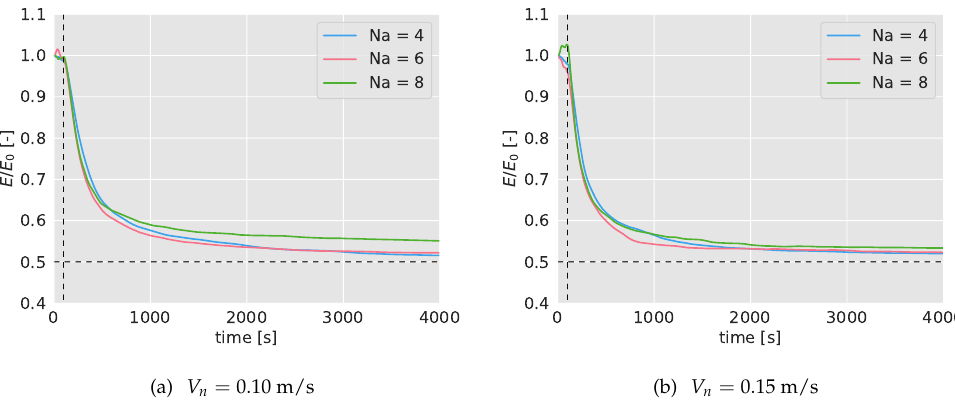
Figure 9. Efficiency of the algorithm over time when half of the agents are forced to land at t = 100 s, marked with a black dashed line. Theoretically, when half of the agents stop working, the efficiency is expected to drop down to 0.5, marked with a black dashed line as well. The efficiency has been normalized with the efficiency without quadcopter failures, E 0